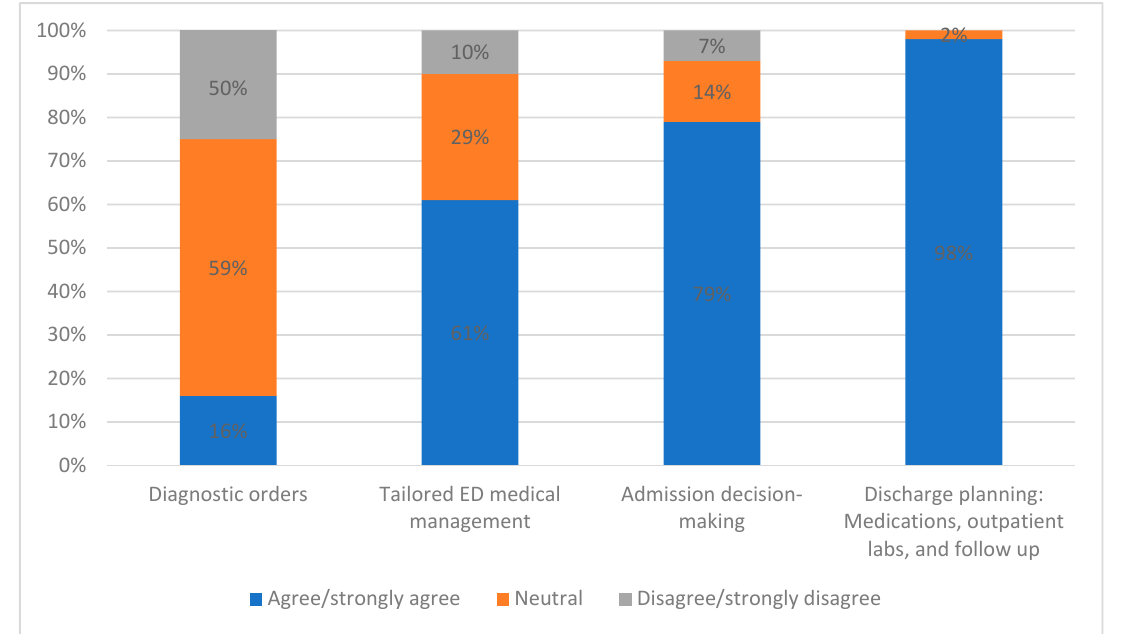
Figure 1. Survey Data: ED providers’ impressions of the clinical areas where personalized, risk-based CDS would be most useful. Bars represent percentage of providers responding “agree/strongly agree”, “neutral”, or “disagree/strongly agree” to each potential motivator of use.